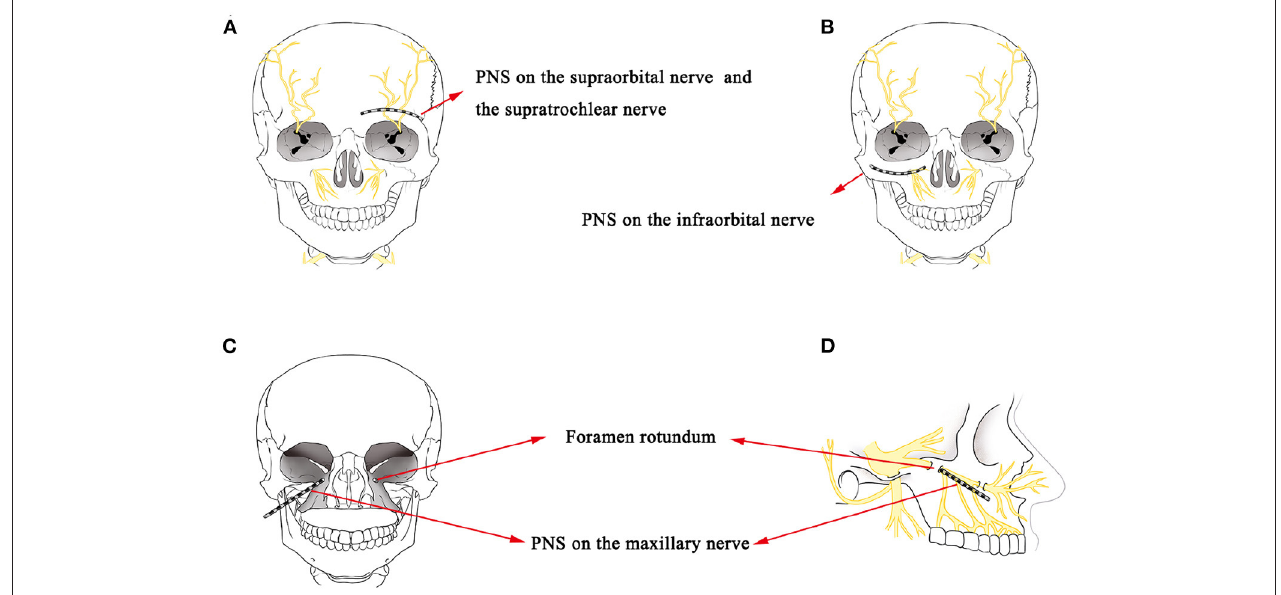
FIGURE 3 | (A) A schematic drawing showing the stimulation lead placement for SON and STN PNS. (B) A schematic drawing showing the stimulation lead placement for ION PNS. (C,D) A schematic drawing of stimulation lead placement for maxillary nerve PNS next to the external opening of the FR.